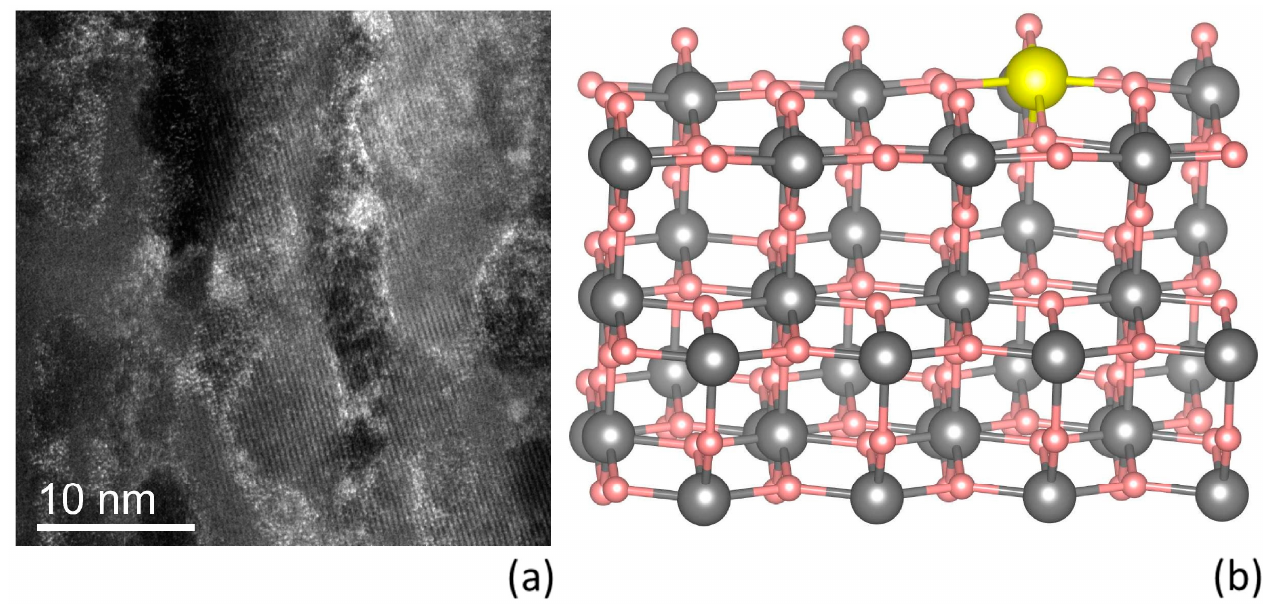
Figure 3. ( a ) STEM image of gig-lox TiO 2 spongy layer after Pb sequestration. The distribution of Pb is uniform both in the meso and nano porosity of the gig-lox sponge. ( b ) Representation of one of the possible configurations of Pb bond with TiO 2 , wherein Pb is substitutional to Ti. In the figure: oxygen is pink; titanium is grey; lead is yellow.